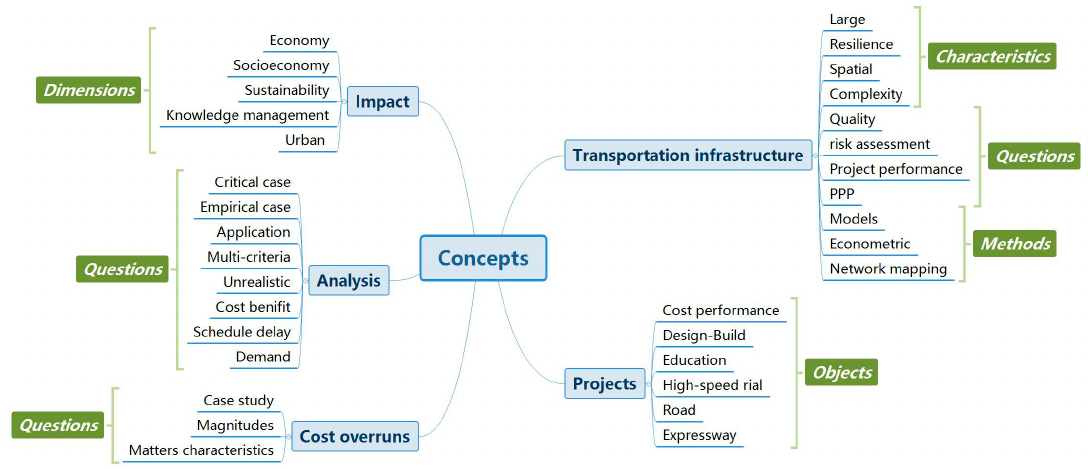
Figure 13. A hierarchy of key concepts in Cluster #0.